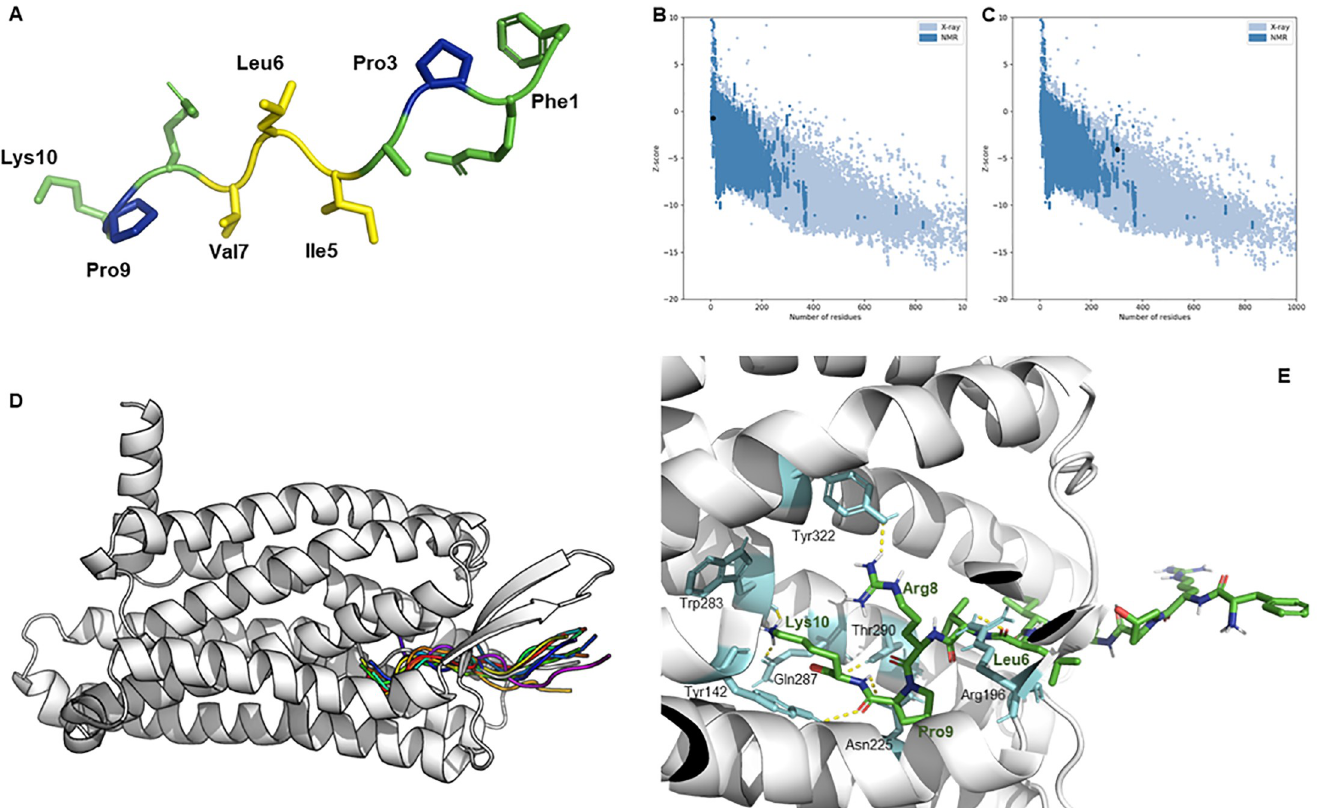
Fig 4. Predicted callitide structure and molecular docking. (A) The 3D-model of callitide predicted by I-TASSER. The hydrophobic residues -ILV- in the middle section were colored in yellow while the two proline residues on the flank were colored in blue. (B, C) The validation of the predicted callitide (B) and BKRB2 (C) models by z-score using ProSA; (D) The peptide callitide cluster in complex with BKRB2. The C-terminus the peptides were inserted into BKRB2, and the peptides were colored; (E) The predicted interactions of callitide-BKRB2. Callitide and the receptor residues predicted to be involved in ligand binding were shown as sticks and labeled. Callitide backbone was colored by green with oxygen atoms colored by red and nitrogen atoms colored by blue. The related residues in BKRB2 were colored as cyan, and yellow dot lines indicated the interactions.